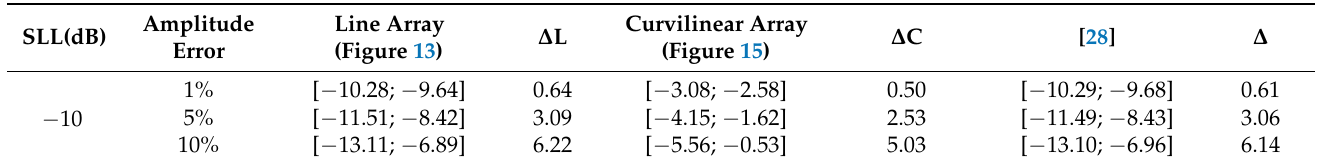
Figure 14. Linear array antenna pattern with excitation phase tolerance (Plane E, Dolph–Chebyshev excitation, the tolerance of MC method is ±2°). Table 2. Numerical results of power pattern in Figures 13 and 15.